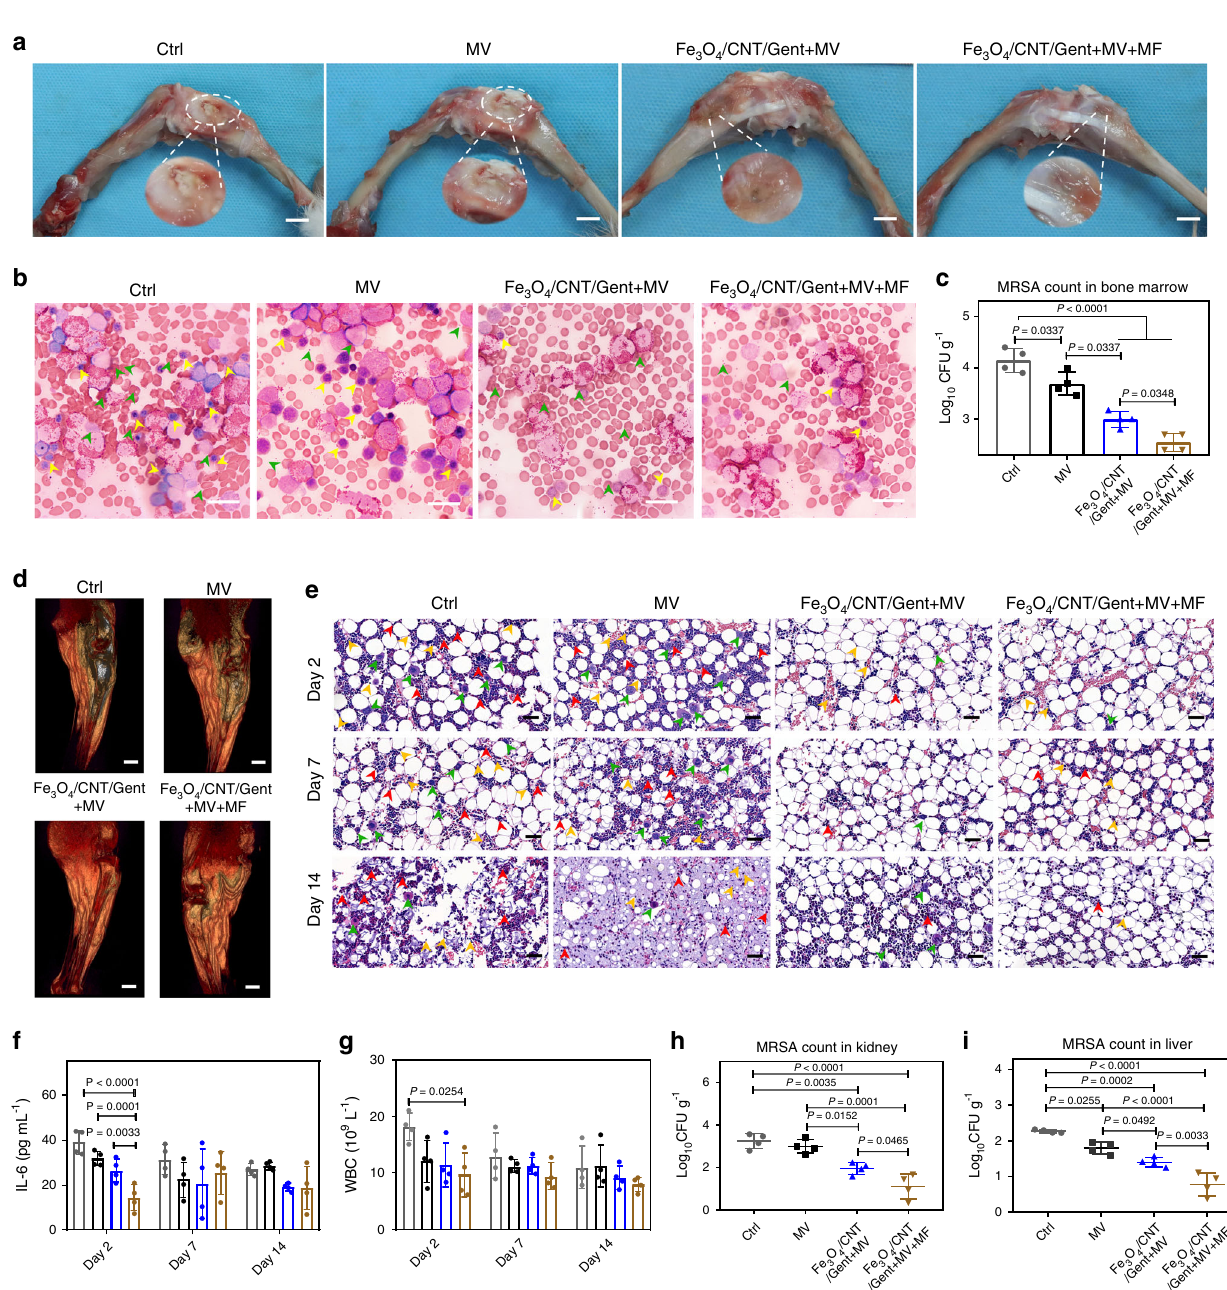
Fig. 6 Antibacterial effects of Fe 3 O 4 /CNT/Gent on MRSA-infected osteomyelitis in vivo. a Macroscopic image of the infected femur and tibia specimens of rabbit models after 14 days of treatment (the festering tissues are indicated by white dashed circles and magni fi ed). Scale bars = 1 cm. b Wright-stained images of infected bone marrow tissue after 14 days of treatment. Scale bars = 20 μ m. c The MRSA counts in the infected bone marrow after 2 days with different treatments. d 3D-MRI after 14 days treatment. Scale bars = 1 cm. e H&E staining images of infected bone marrow tissues after 2, 7, and 14 days of treatment. Scale bars = 50 μ m. IL-6 levels ( f ) and amount of WBC ( g ) from 2 to 14 days in blood. At 14 days post-treatment, samples were collected from harvested kidneys ( h ) and livers ( i ) for bacterial quanti fi cation. Data are presented as mean ± standard deviations from a representative experiment ( n = 4 biologically independent samples). P values were analysed by one-way ANOVA with Tukey ’ s multiple comparisons post hoc test. Grey circles indicate the group of Ctrl, black circles indicate the group of MV, blue circles indicate the group of Fe 3 O 4 /CNT/Gent + MV, brown circles indicate the group of Fe 3 O 4 / CNT/Gent + MV + MF. Source data are provided as a Source Data fi